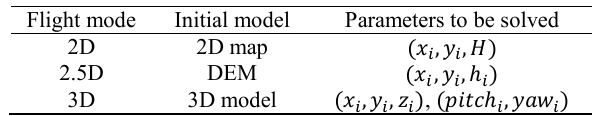
Table 1 . The characteristics of different flight modes.